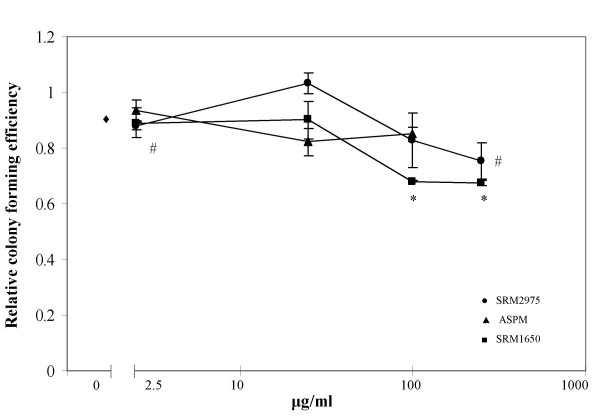
Colony forming ability expressed as relative to the number of colonies in the control, which are set to 1. The dots represents mean ± SEM; (n = 3). Decreased colony forming ability of cell cultures exposed to SRM2975 (#) SRM1650 (*) compared to the unexposed cultures (p < 0.05, Kruskal-Wallis test).